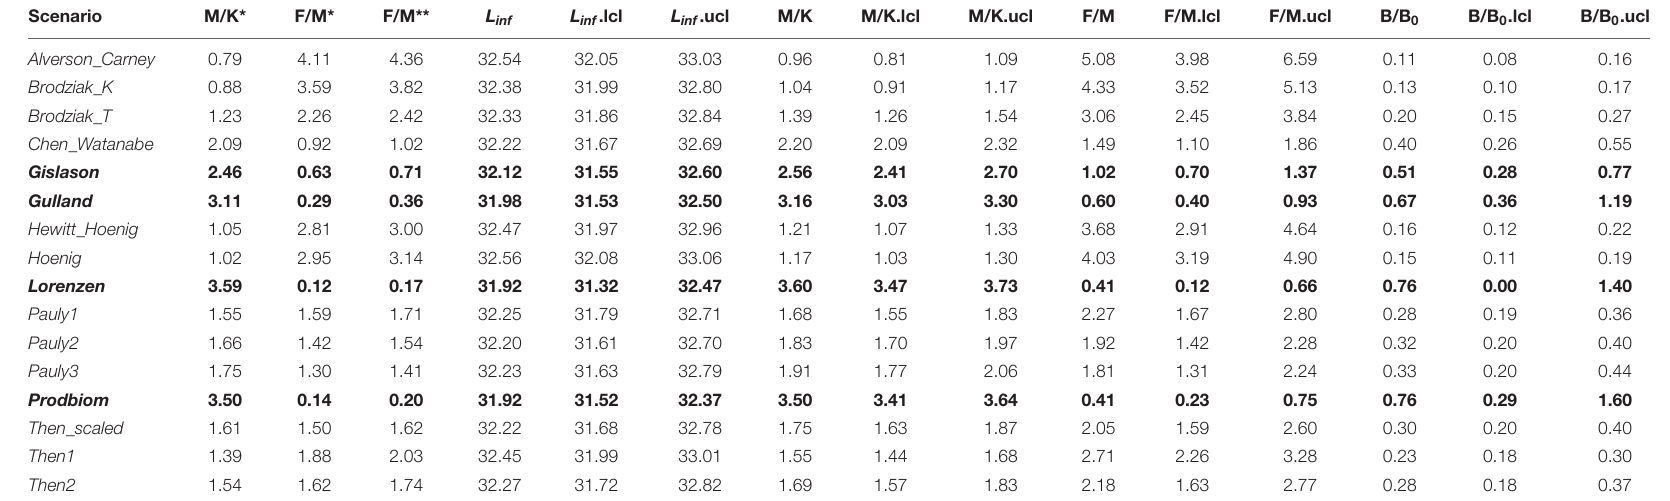
TABLE 5 | Length-based Bayesian Biomass method (LBB) estimates of asymptotic length ( L inf ), natural mortality relative to somatic growth rate (M/K), fishing mortality relative to natural mortality (F/M) and current biomass relative to unexploited biomass (B/B 0 ) by M scenario.